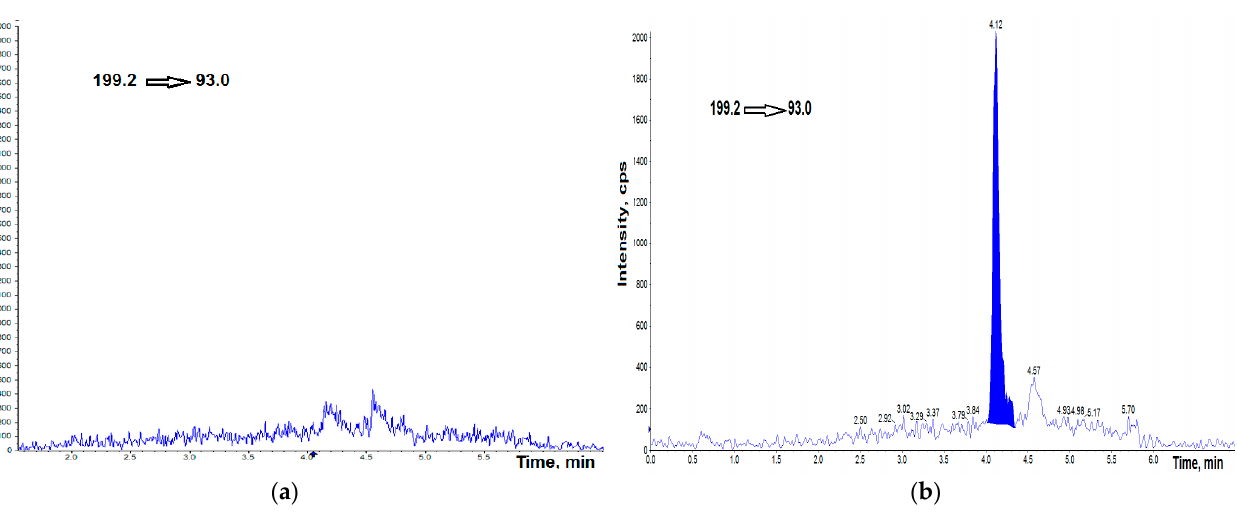
Figure 3. UHPLC–MS/MS chromatogram of bisphenol A-d 16 (IS) at concentration of 2.5 ng mL − 1 . cps—counts per second.